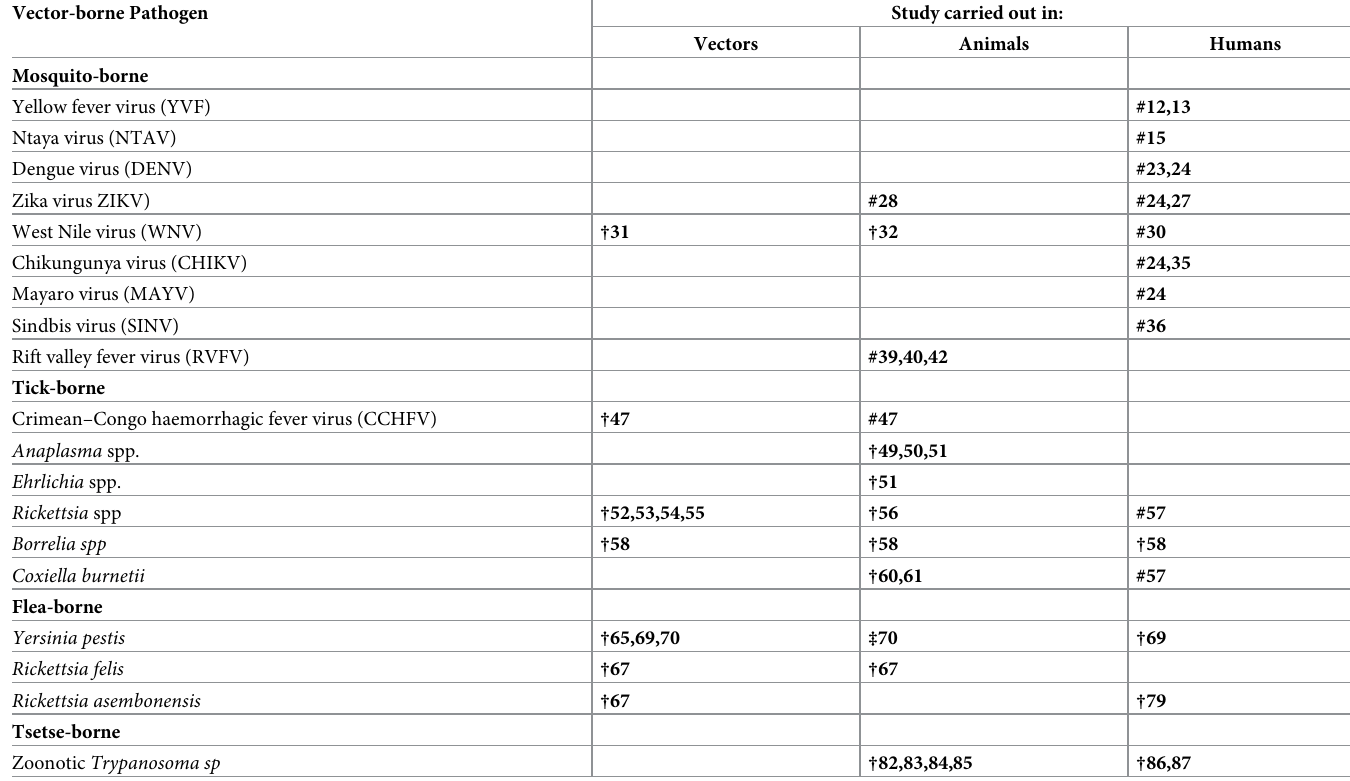
Table 1. Studies reporting the serologic and/or molecular detection of vector-borne pathogens either in vectors and/or animals including humans in Zambia. Vector-borne Pathogen Study carried out in: Vectors Animals Humans Mosquito-borne